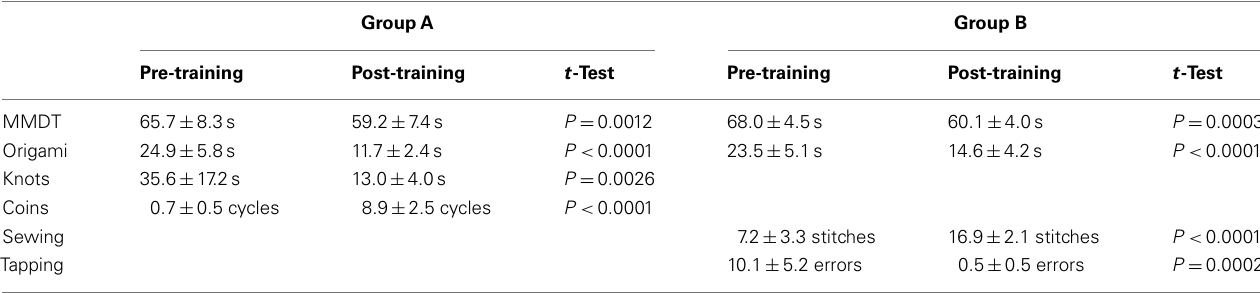
Table 2 | Pre- and post-training motor dexterity